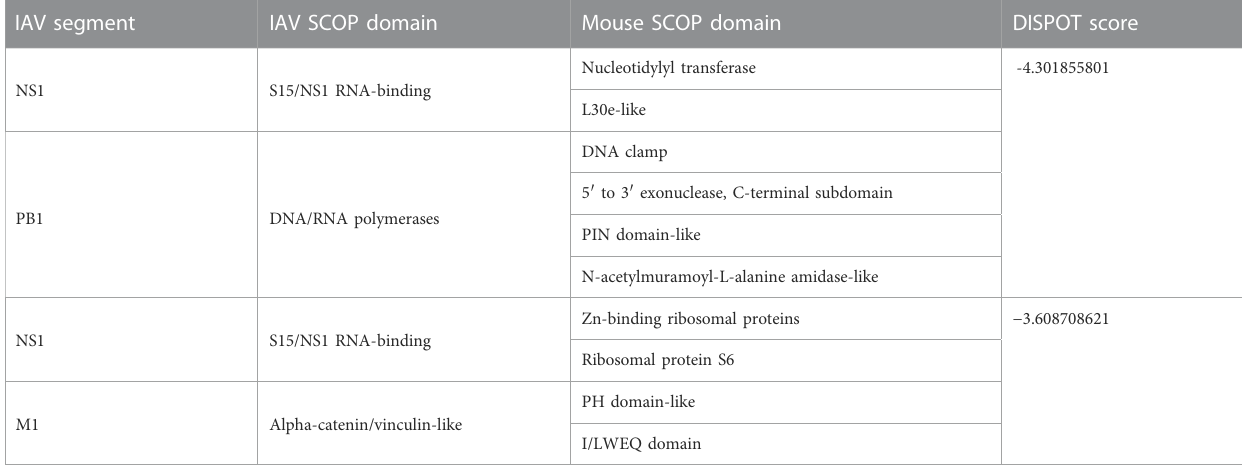
TABLE 4 Top 10 Interactions according to statistical potentials returned by DISPOT. A more negative DISPOT score indicates a higher possibility of interaction.